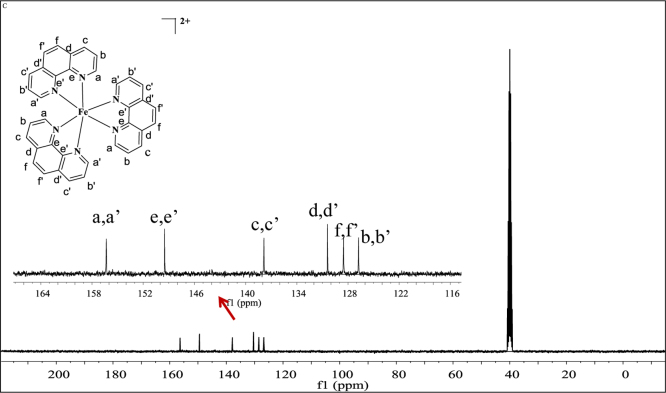
13C NMR spectrum (300 MHz) of complex 2 in dimethylsulfoxide-d6.